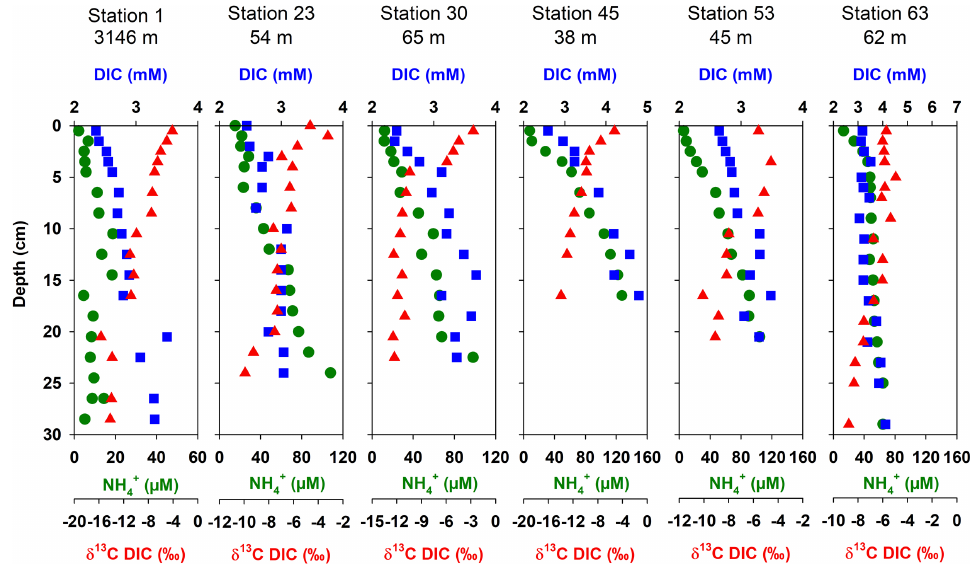
) for Stations 1, 23, 30, 45, 58, and